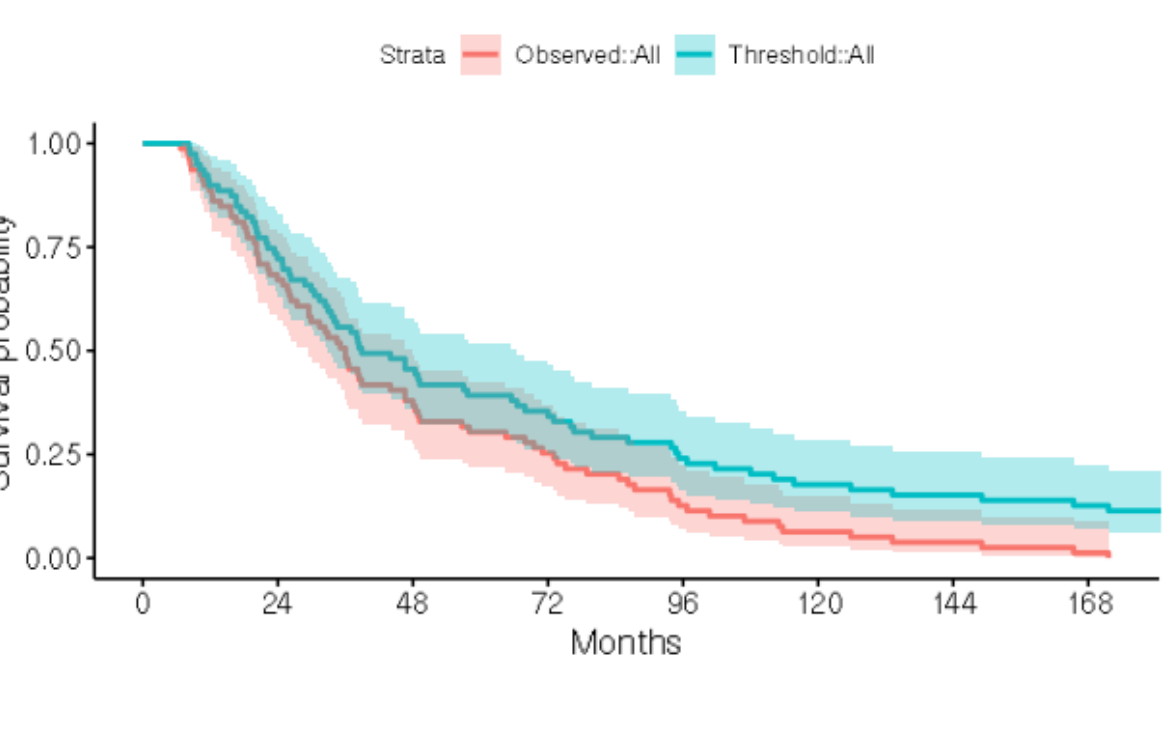
Figure 3. Accuracy of predicted timing of recurrence expressed via a comparison of Kaplan-Meier curves for observed (red) versus predicted (blue) time to SBCE among test set cases with a SBCE, where the predicted time to SBCE is based on a threshold probability of 0.5. Cases for whom no SBCE is predicted (monthly predicted probabilities never exceed 0.5) are censored at their last follow-up time. SBCE: second breast cancer